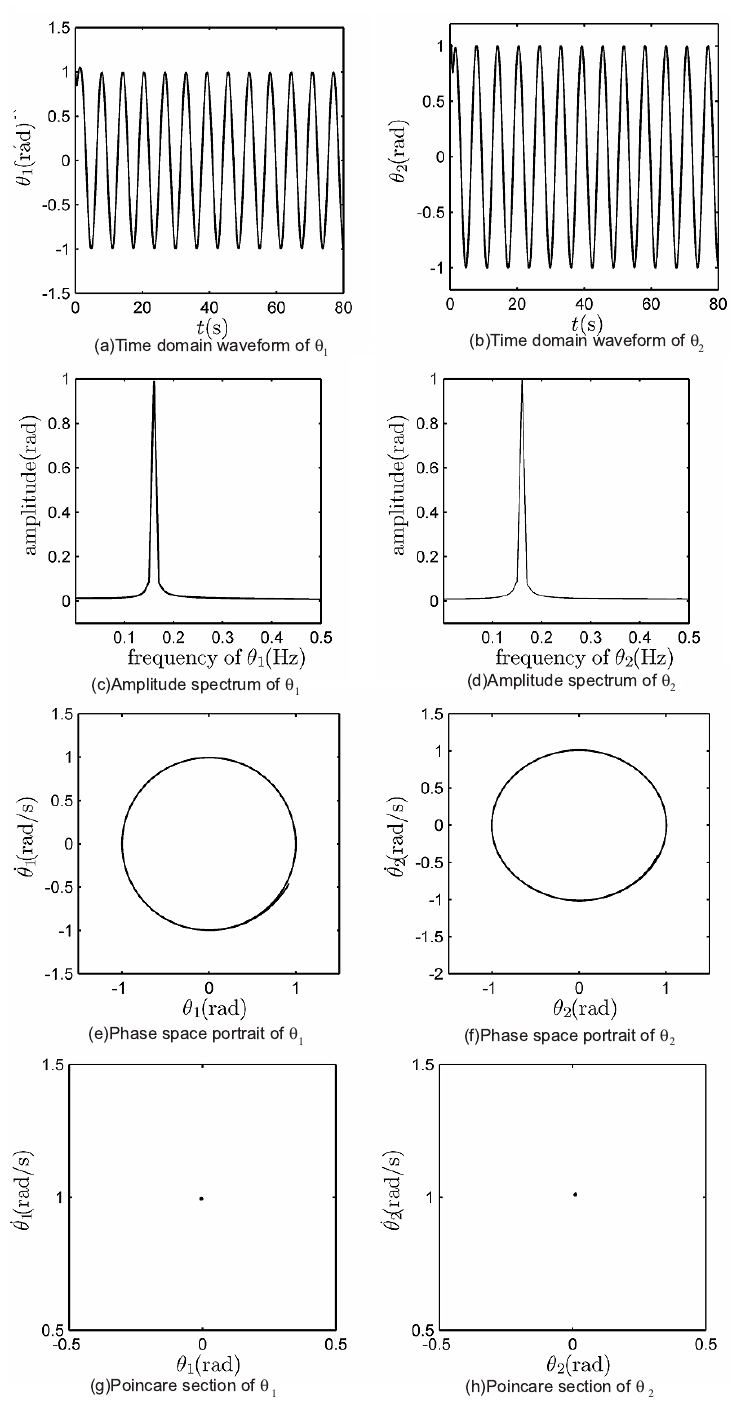
Fig. 3. The simulated single-periodic motions [(a) Time domain waveform of θ 1 , (b) Time domain waveform of θ 2 , (c) Amplitude spectrum of θ 1 , (d) Amplitude spectrum of θ 2 , (e) Phase space portrait of θ 1 , (f) Phase space portrait of θ 2 , (g) Poincare section of θ 1 , (h) Poincare section of θ 2